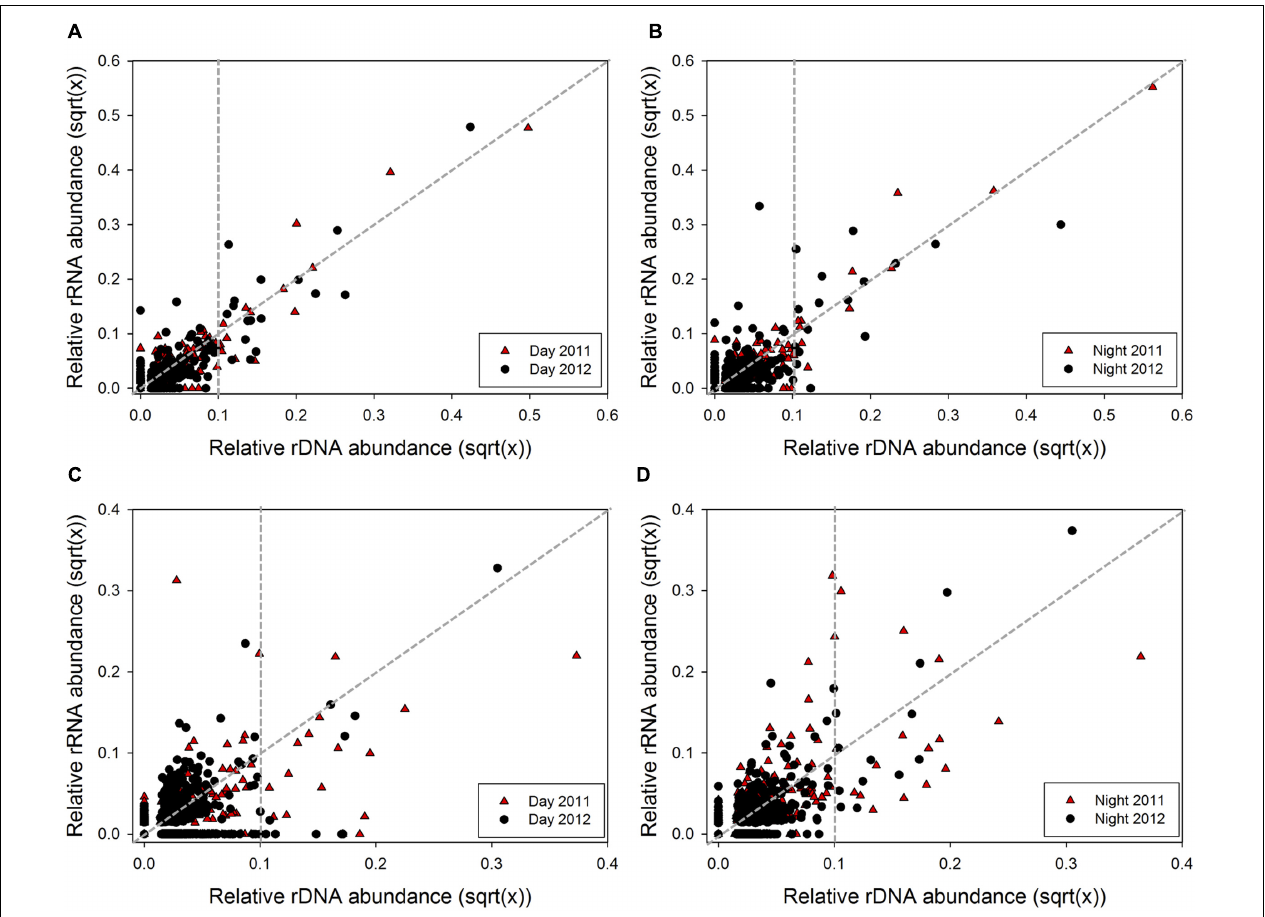
FIGURE 2 | Relationship between rRNA and rDNA abundance for each OTU defined by 16S rRNA and 16S rRNA gene MiSeq sequencing dataset for subsampled communities comparing 2011 (black) and 2012 (red). Archaeal (A) day ( n day2011 = 277, n day2012 = 330) and (B) night ( n night2011 = 249, n night2012 = 367); and bacterial (C) day ( n day2011 = 372, n day2012 = 697), and (D) night ( n night2011 = 347, n night2012 = 621). Data points in graph are square root transformed paired relative rRNA and rDNA abundances for each OTU. Vertical gray dashed line differentiates between rare and abundant OTUs (rare < 0.1%, abundant > 0.1% rDNA abundance). Data points above and below the 1:1 line represent OTUs with higher and lower PSP,